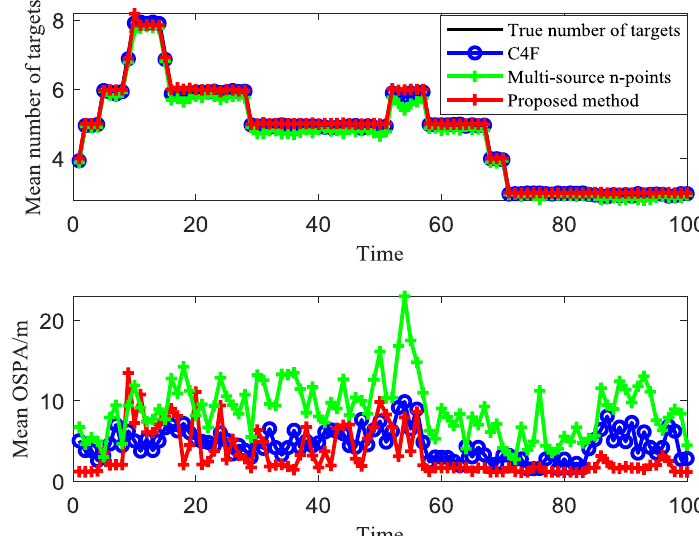
Figure 11. Mean estimated number of targets and mean OSPA of different algorithms over 100 MC trials.